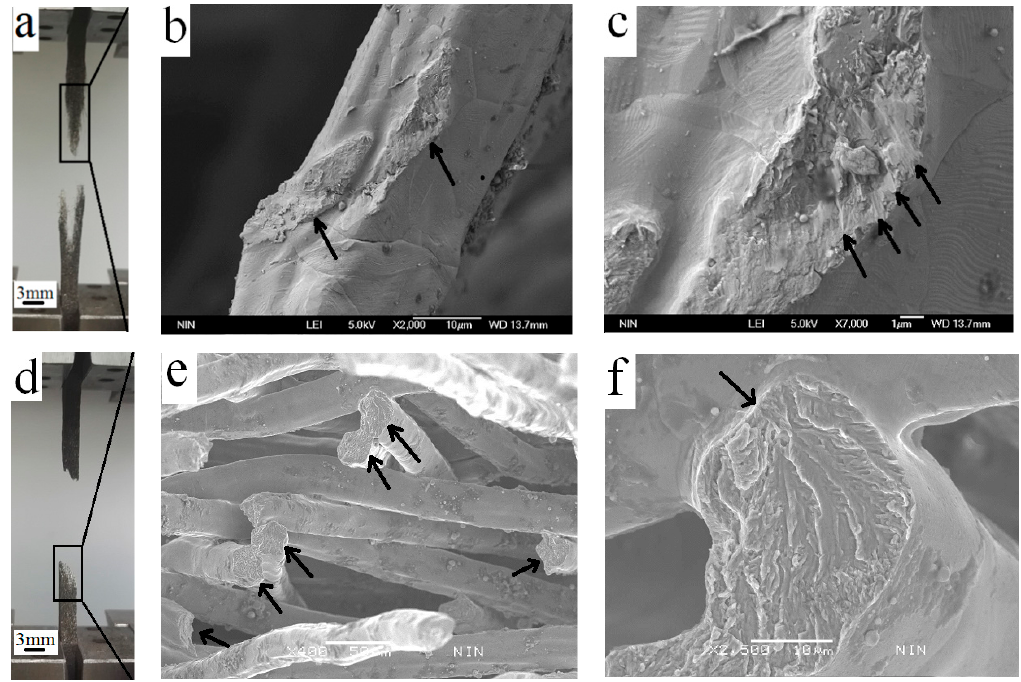
Figure 11. Fatigue failure mode of sample II ( a – c ), and sample VII ( d – f ).